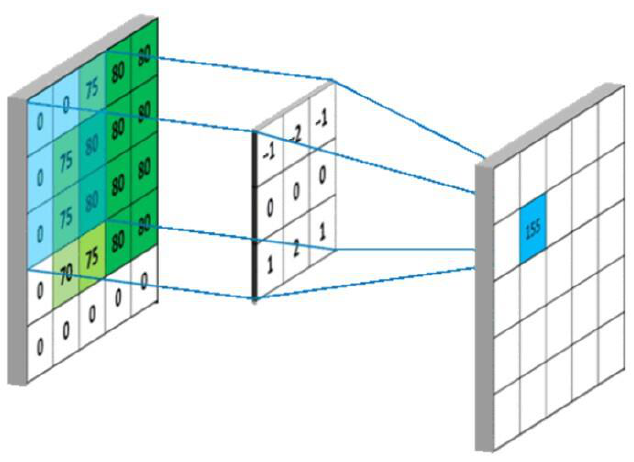
Figure 3. Convolutional layer output diagram.